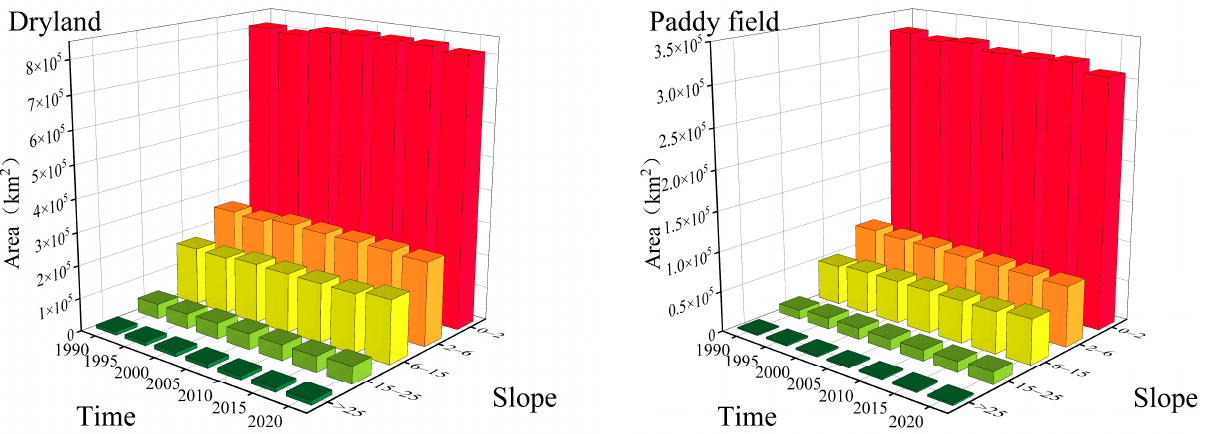
Figure 3. Change in the slopes of paddy field and dryland. (For detailed data, refer to Table S3 in the Supplementary Materials).